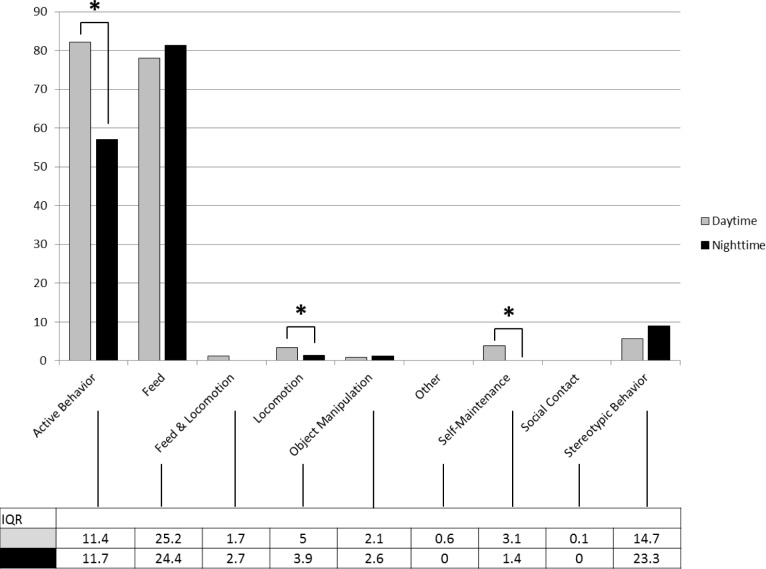
Median Day and Nighttime active behavior percentages.Asterisks represent significant period differences (p<0.05). In the Daytime and Nighttime, median values for Other and Social Contact were zero. The median value for Feed & Locomotion was also zero during the Nighttime.